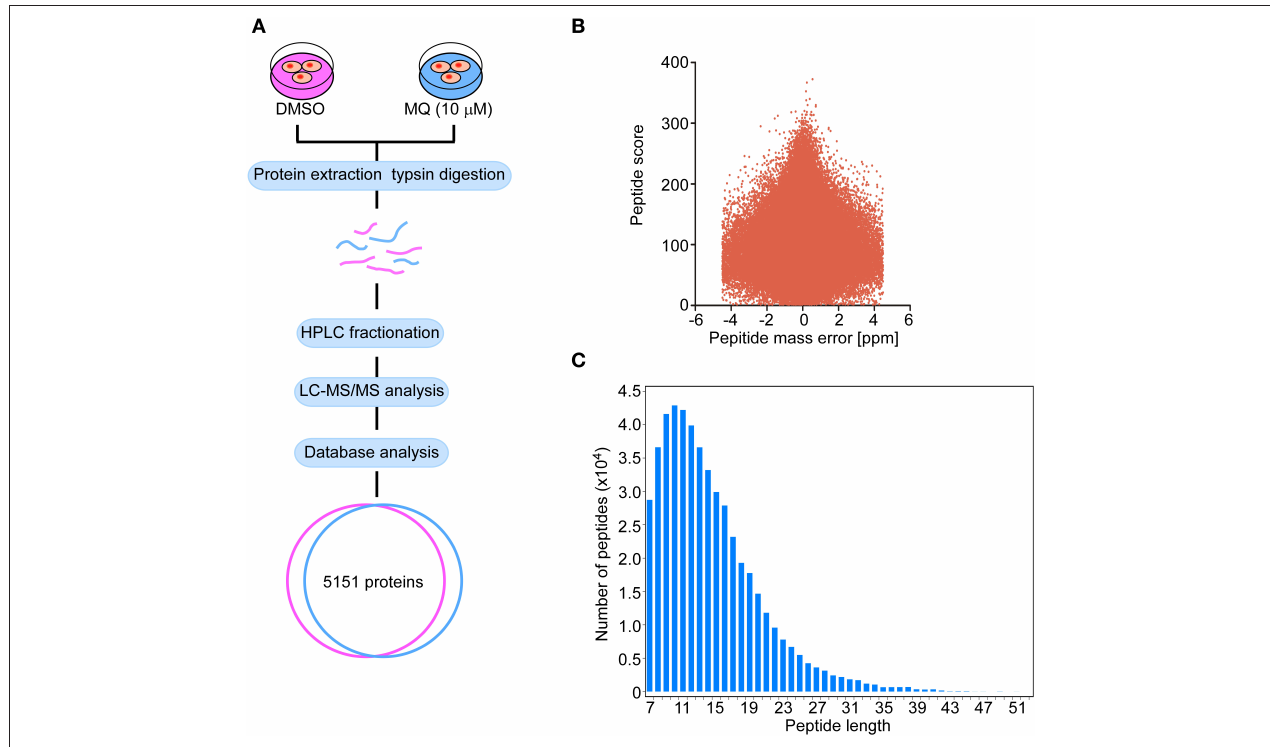
FIGURE 2 | Flow graph of proteomics. (A) Schematic diagram of the quantitative proteomics analysis process. KYSE150 cells were treated with DMSO or MQ (10 µ M) for 24h, after LC-MS/MS analysis, 5,151 proteins were identified in the overlap section between DMSO and MQ (10 µ M) groups. (B) Volcano diagram indicated the distribution of 5,151 proteins identified. Peptide mass error was plotted as x axis, the peptide score was plotted as y axis. (C) The distribution of peptide length of 5,151 proteins identified. Peptide length was plotted as x axis, the number of peptides was plotted as y